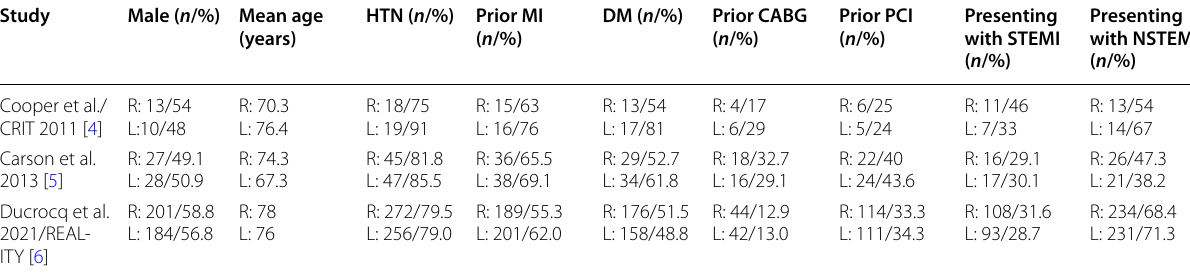
Table 2 Baseline patient characteristics